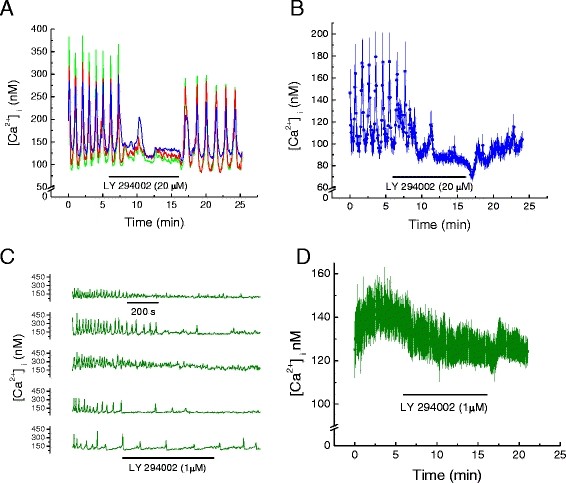
Phosphoinositide-3-kinase (PI3K) inhibition decreases intracellular Ca
2+
, [Ca
2+
]
i
, in HL-1 cell mouse cardiomyocytes.
A
. Effect of LY294002 (20 μM) on oscillations of [Ca2+]i in three HL-1 cells showing synchronous oscillations of [Ca2+]i.
B
. Effect of LY294002 (20 μM) on average [Ca2+]i in cells displaying oscillating and non-oscillating [Ca2+]i (mean ± SEM; n = 37 cells).
C.
 Effect of LY294002 (1 μM) on [Ca2+]i oscillations in five representative HL-1 cells. Time base applies to all traces.
D
. Effect of LY294002 (1 μM) on average [Ca2+]i in cells displaying oscillating and non-oscillating [Ca2+]i (mean ± SEM; n = 5, each an average of 25 to 40 cells as shown in C).